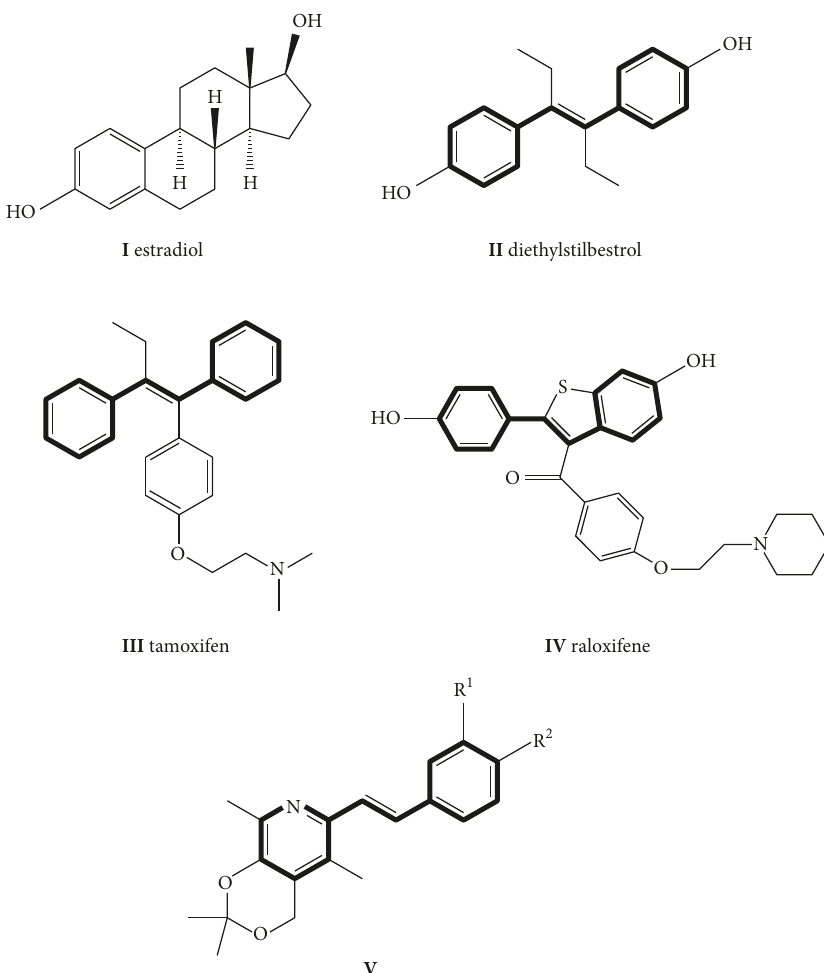
Figure 1: The natural ER agonist estradiol (I) , examples of ER targeting drugs (II – IV) , and compounds studied in this work (V) ; highlighted is the trans -diarylethylene motif characteristic of the bioisosteric analogs of the natural